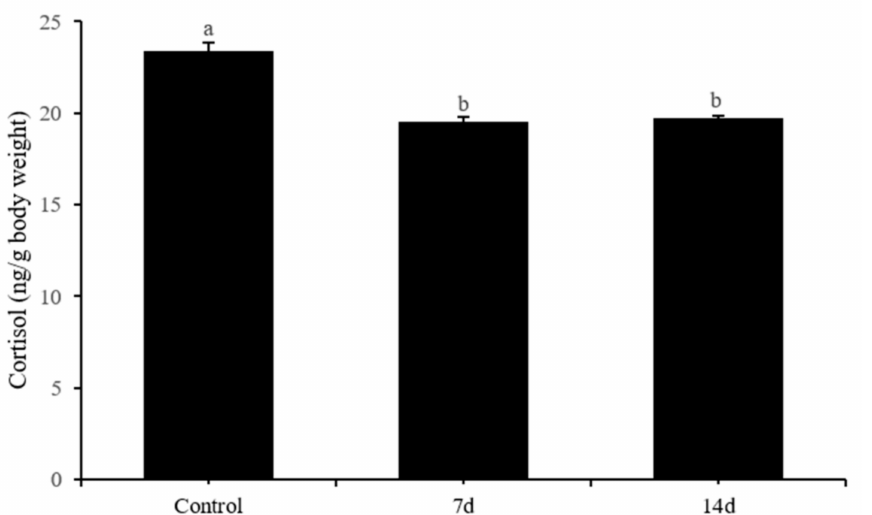
Figure 9. Effects of 7 and 14 days of the UCS protocol on cortisol levels in rare minnow. Data are expressed as mean ± SD (n = 3). Three pooled samples of two fish each from each treatment. The different letters in the bar indicate significant differences between the two groups ( p < 0.05).